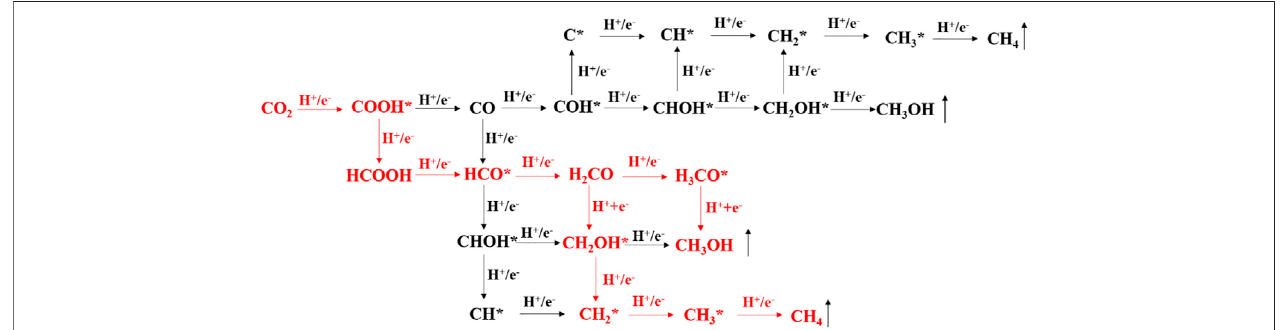
FIGURE 8 | The possible reaction paths and intermediates of CO 2 reduction by hydrogenation of C and O. The red part is the optimal reaction path on the BiOBr/ g-C 3 N 4 and BiOBr/S-g-C 3 N 4 .